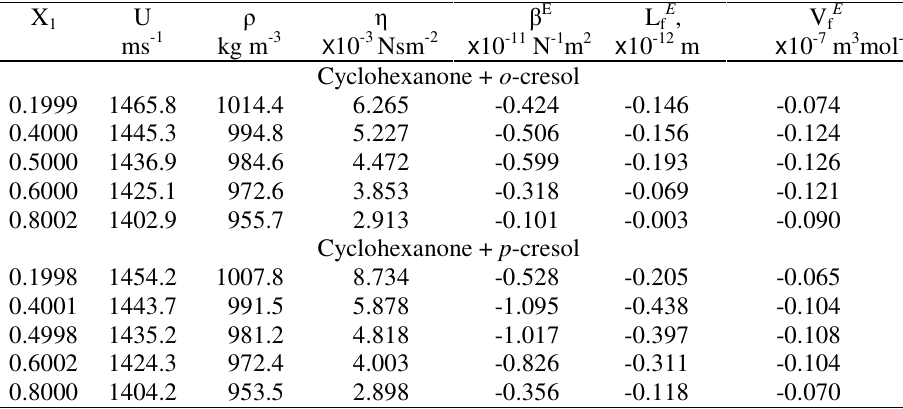
Table 1 . Experimental values of ultrasonic velocity (U), density ( ρ ), viscosity ( η ) and excess values of adiabatic compressibility ( β E ), free length (L cyclohexanone + o -cresol, p -cresol at 303